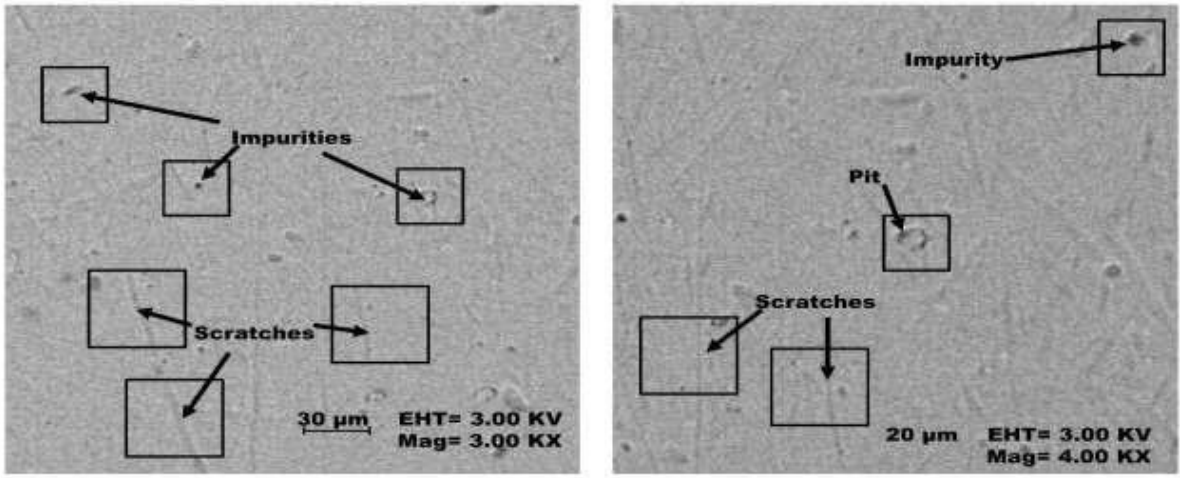
Fig. 3. SEM images of TiAlN coated steel balls: (a) at (X 3.00 K) and (b) at (X 4.00 K)